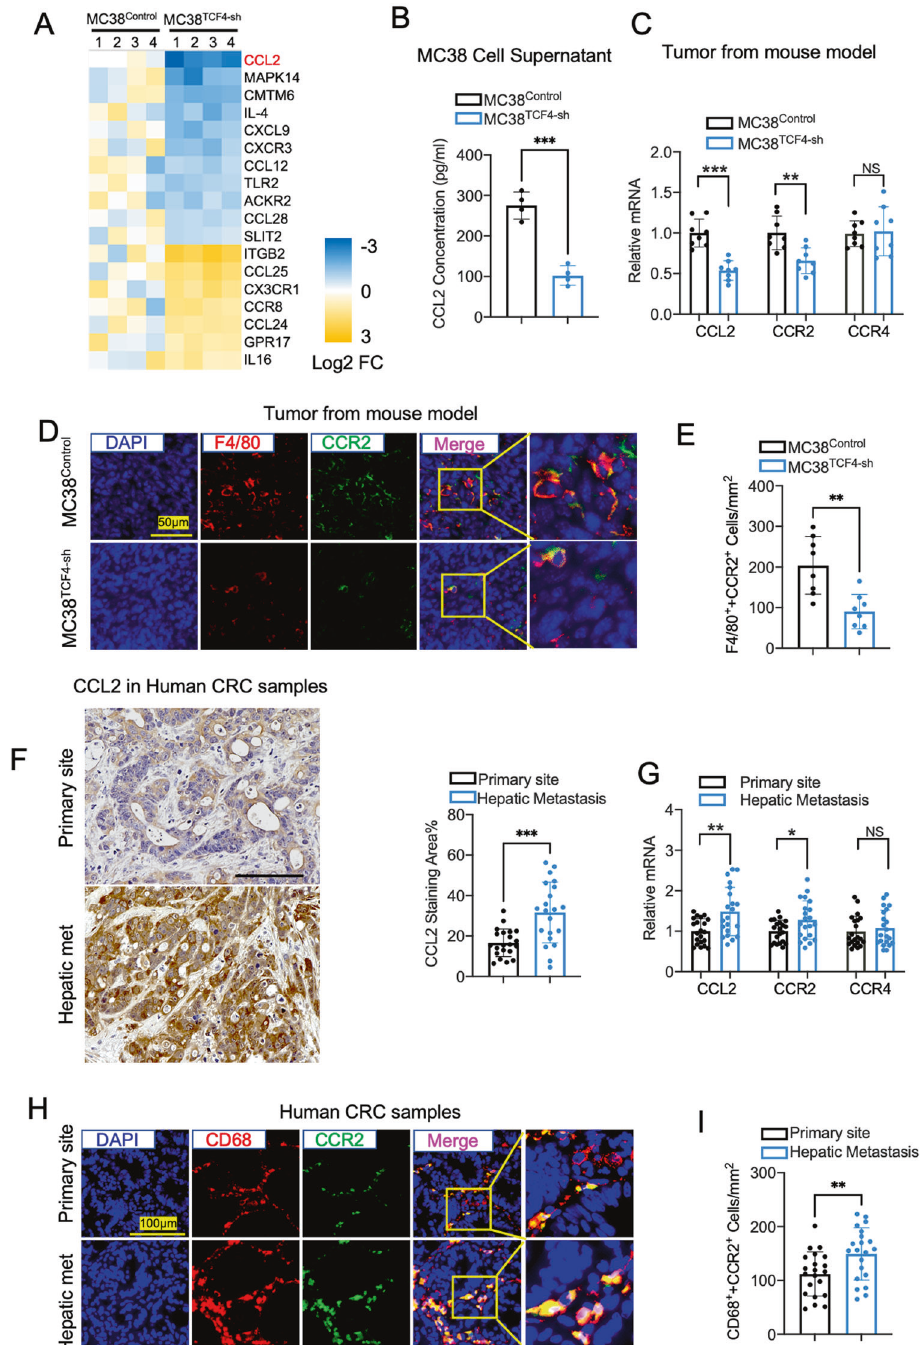
Fig. 5 TCF4 enhances TAM recruitment and M2 polarization in the tumor through regulating the CCL2-CCR2 axis. A A heatmap of differential expression genes between MC38TCF4-sh cells compared with MC38Control cells using a chemokine PCR array. n = 4, per group. B CCL2 protein concentrations in the culture medium of MC38Control and MC38TCF4-sh cells were evaluated by ELISA. n = 4, per group. C CCL2, CCR2 and CCR4 mRNA expression in metastatic hepatic tumors of mice model received MC38Control and MC38TCF4-sh cells spleen injection. n = 8 per group. D Representative images of Immuno fl uorescence staining for F4/80(red), CCR2 (green) and DAPI (blue) in mouse hepatic metastases. Scale bar, 50 μ m. E Quanti fi cation of F4/80 and CCR2 double positive cells per mm 2 tumor area. n = 8 per group; fi ve fi elds were counted per sample. F CCL2 Immunohistochemistry staining and quanti fi cation in the human primary colorectal cancer and hepatic metastatses. Scale bar, 100 μ m. Primary cancer, n = 21; hepatic metastases, n = 21; fi ve fi elds were counted per sample. G Q-PCR results of CCL2, CCR2, and CCR4 mRNA expression in human primary colorectal cancer and hepatic metastatses. H Representative images of Immuno fl uorescence staining for CD68(red), CCR2(green) and DAPI(blue) in human primary colorectal cancer and hepatic metastatses. Scale bar, 100 μ m. I Quanti fi cation of CD68 + CCR2 + cells per mm2 tumor area. Primary cancer, n = 21; hepatic metastases, n = 21; fi ve fi elds were counted per sample. Data are means ± SEM. * P < 0.05, ** P < 0.01, *** P < 0.005, **** P <